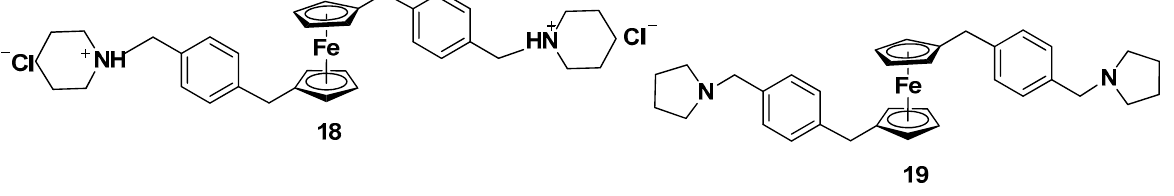
Figure 10. Complexes based on ferrocene structure.